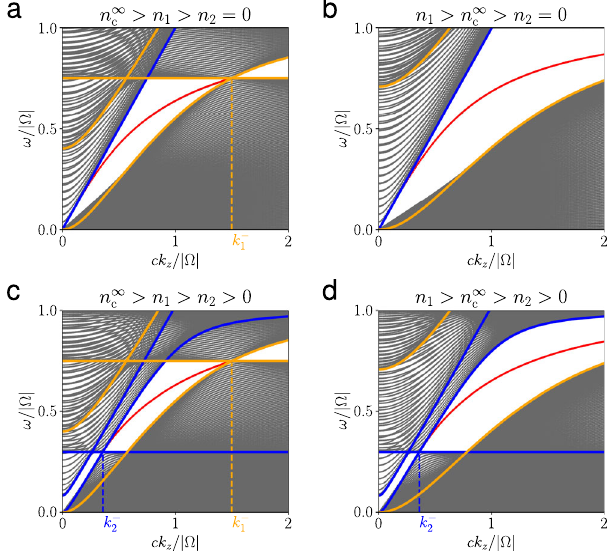
Fig. 5 Four possible types of Fermi-arc-like structures. a – d Band structure ω ( k z ) at k y = 0 with different parameters, where Fermi-arc-like structures of edge mode connecting Weyl points. The topological edge modes are highlighted by the red curves. The bulk modes of the inner and outer plasmas when k ⊥ = 0 are highlighted by orange and blue curves, respectively. The other bulk modes are indicated by gray curves. k (cid:2) ¼ k (cid:2) ð ω Þ and k (cid:2) ¼ k (cid:2) ð ω Þ . The plasma frequencies ( ω p,1 , ω p,2 )/ ∣ Ω ∣ in p ; 1 p ; 2 1 2 ( a ) – ( d ) are (0.75, 0), (1.1, 0), (0.75, 0.3), and (1.1,